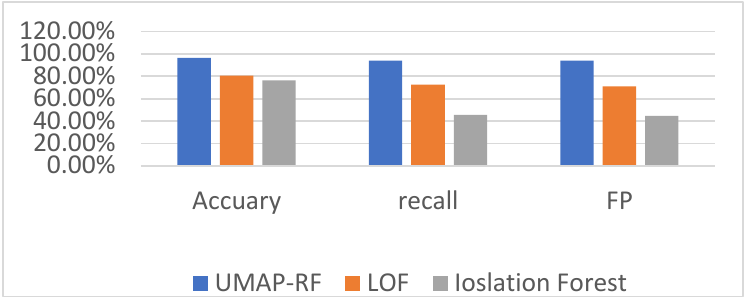
Figure 8. Comparison histogram of experimental results of different algorithms for NSL-KDD da- taset.